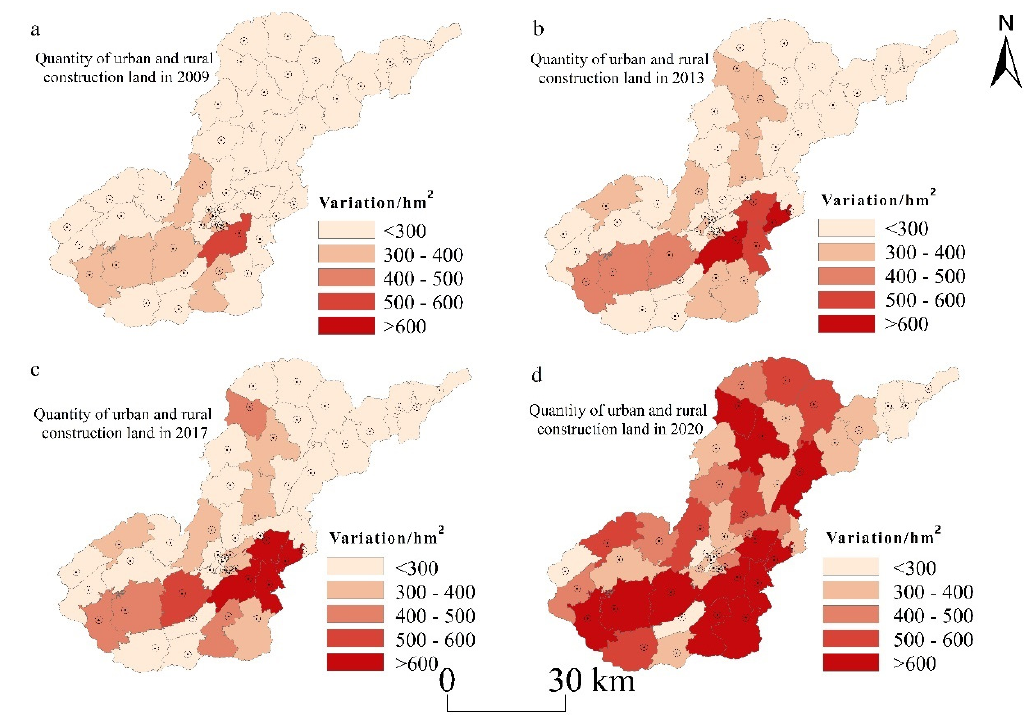
Figure 2. Spatial distribution of urban–rural construction land characteristics in Qixingguan District from 2009 to 2020.